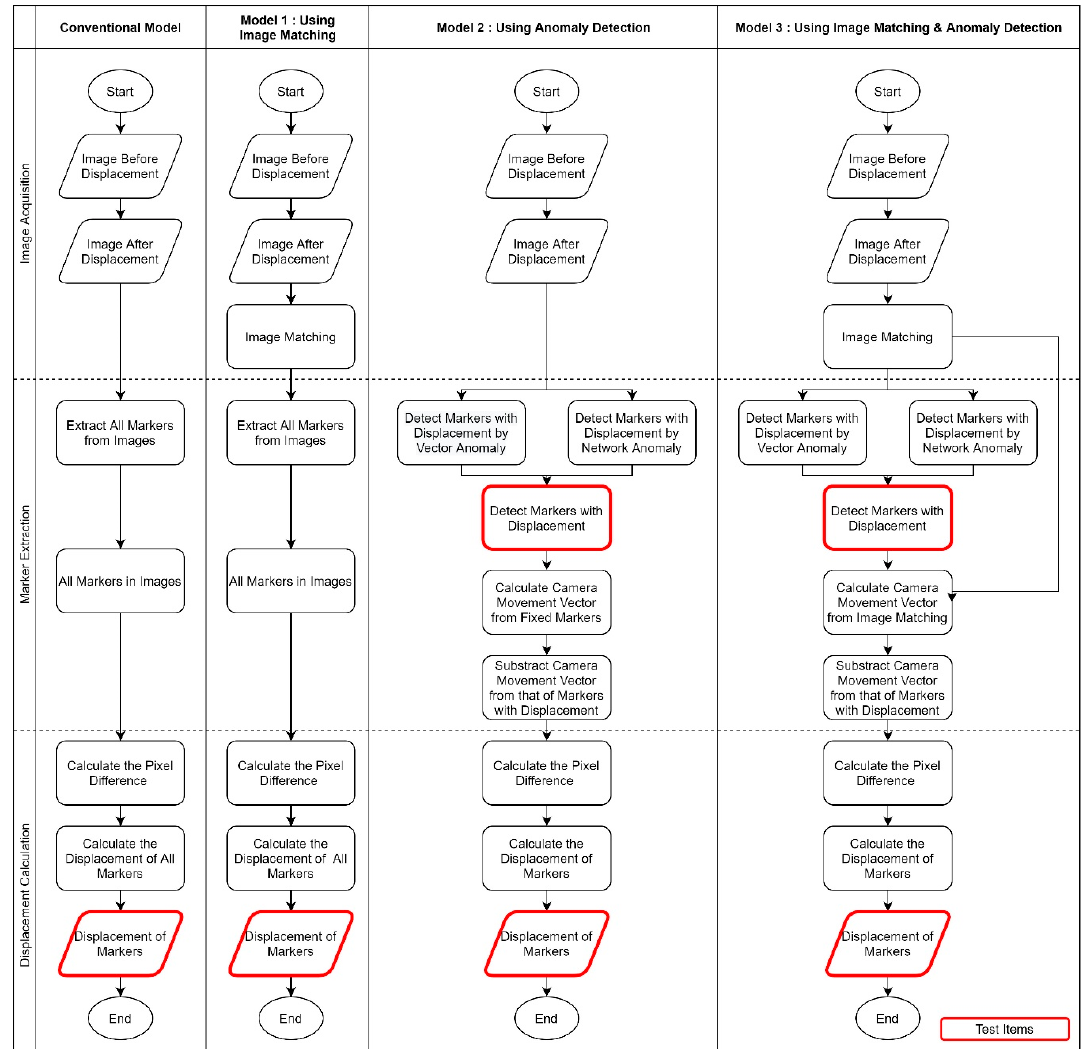
Figure 6. Flowchart of designed models compared with the conventional model.